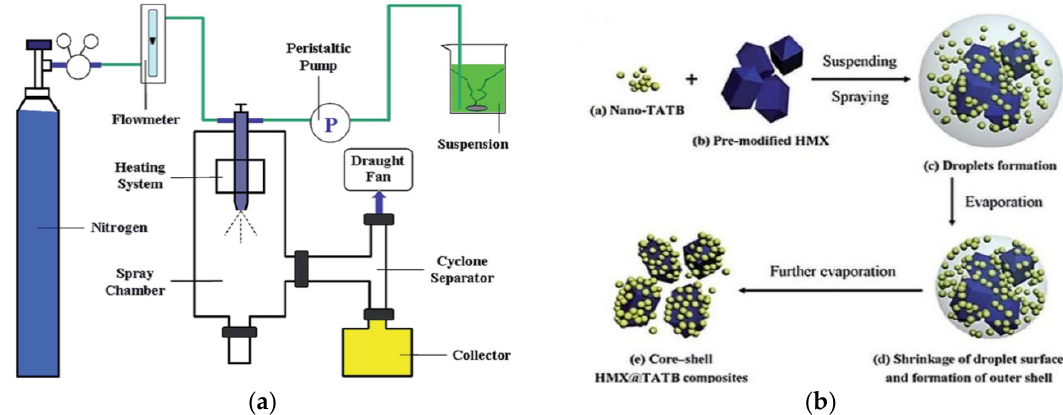
Figure 4. ( a ) Experimental apparatus of spray drying technique; ( b ) formation mechanism of HMX@TATB composite. ( a , b ) Reproduced with permission from [85], copyright 2015, the Royal Society of Chemistry.